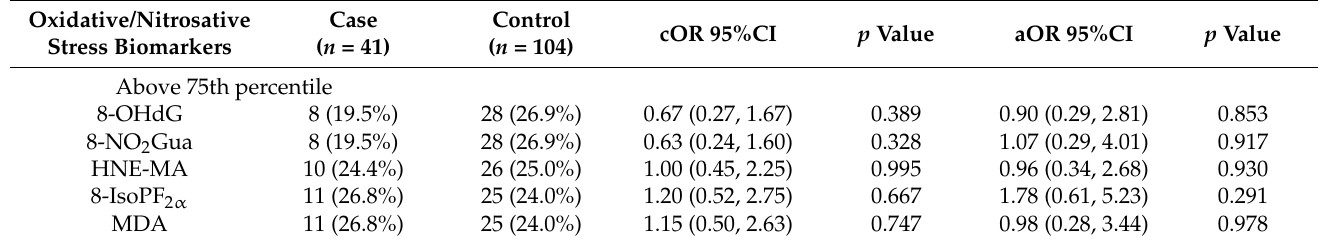
Table 5. Crude odds ratio (cOR) and adjusted odds ratio (aOR) for high oxidative/nitrosative stress biomarkers in the case and control groups.